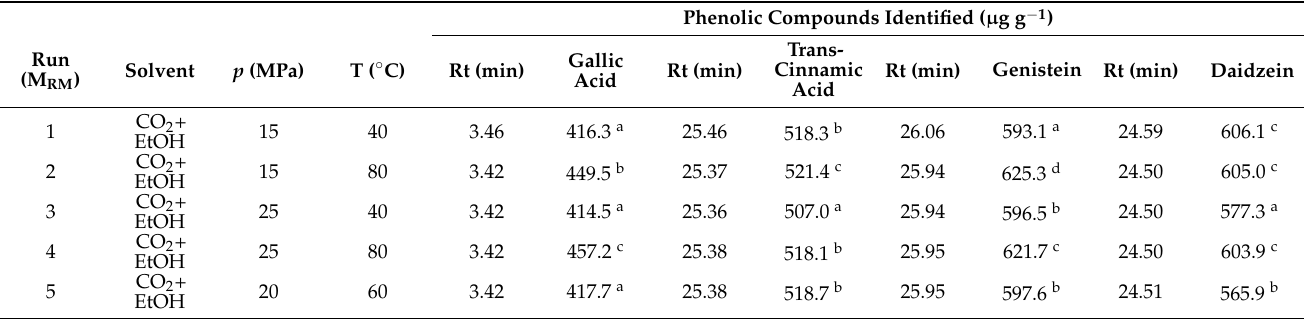
Table 5. Results of the identification of phenolic contents by high-performance liquid chromatography.